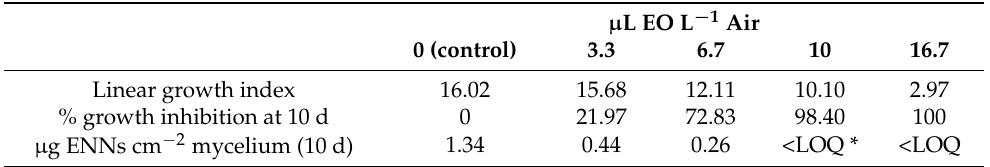
Table 5. Linear growth index of F. avenaceum and ENNs accumulation after 10 days in presence of different quantities of A. pusilla EO (AP1) volatile components.